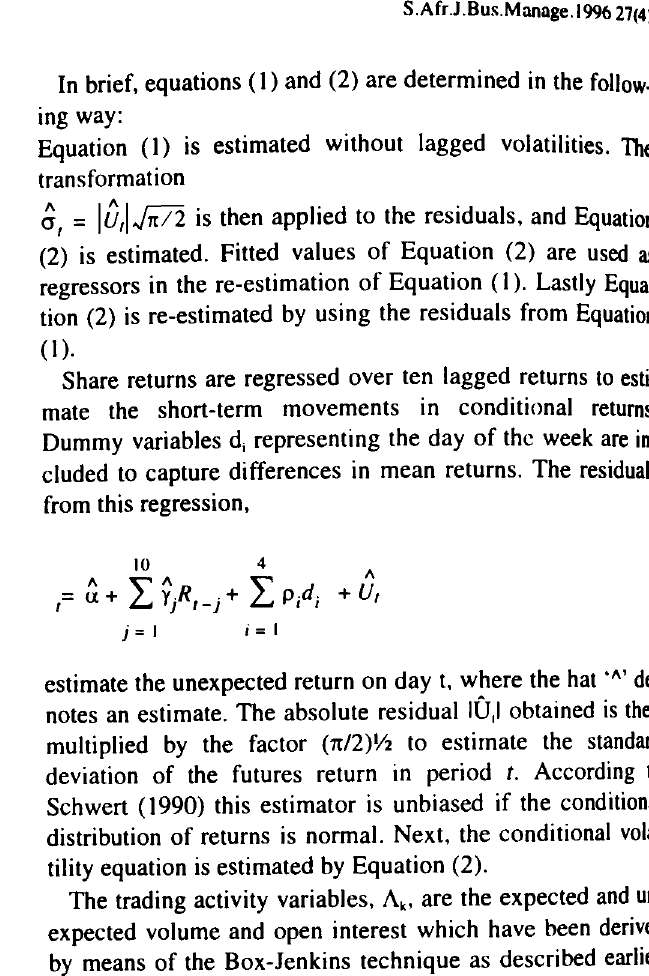
Table 4 ARIMA models used for establishing expected and unexpected returns and open